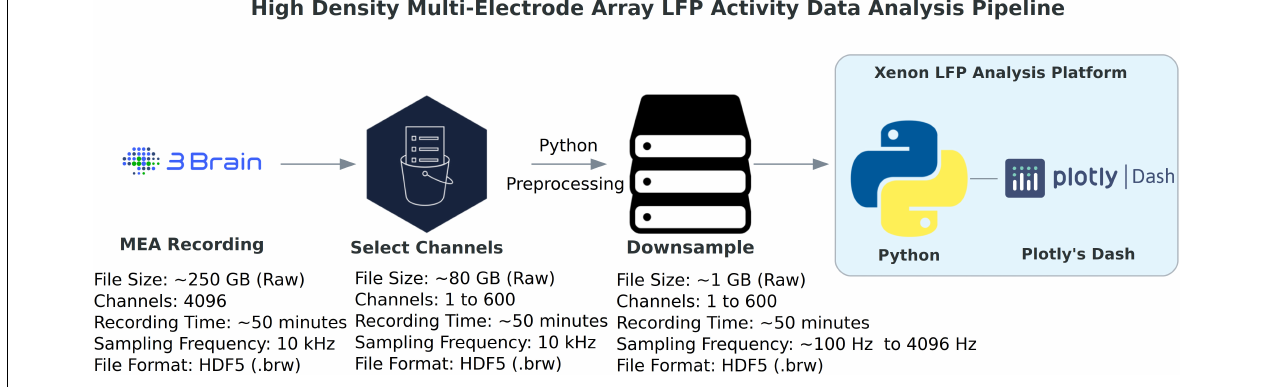
FIGURE 1 | High-density multi-electrode array (HD-MEA) data-analysis pipeline. The data processing for LFP activity detection and network analysis starts by selecting a group of about 600 channels that overlay the brain slice or region of interest, which are exported from the original hdf5 measurement raw file (4,096 channels, sampled at 10 kHz) to a reduced hdf5 file. This reduced file is further downsampled from 10 kHz to a desired frequency. This will be the working hdf5 file for the Xenon LFP Analysis Platform. (3Brain Logo: © Copyright 3Brain AG, Python Logo: © Copyright Python Software Foundation, Plotly’s Dash Logo: © Copyright Plotly).